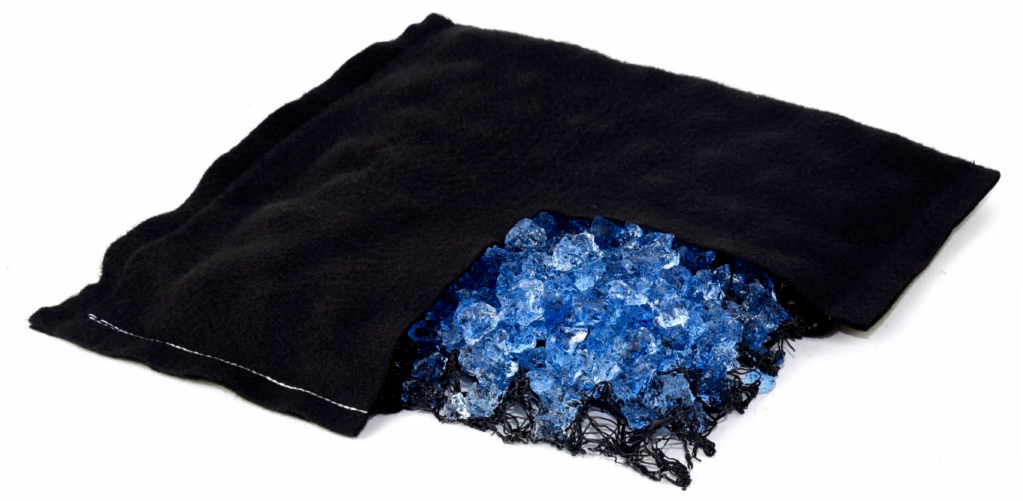
Figure 2. Cross-section of water absorbing geocomposite. Visible nonwoven geotextile, spatial openwork structure and superabsorbent polymer in a saturated